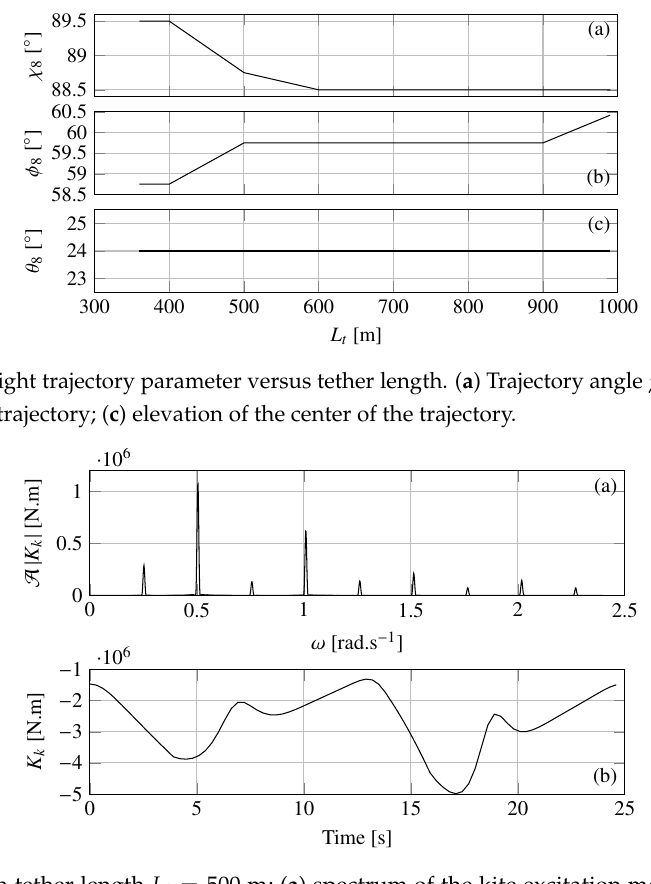
Figure 11. With a tether length L t = 500 m; ( a ) spectrum of the kite excitation moment around the longitudinal ship axis x s ; ( b ) time history of the kite excitation moment around the longitudinal ship axis x s over the last